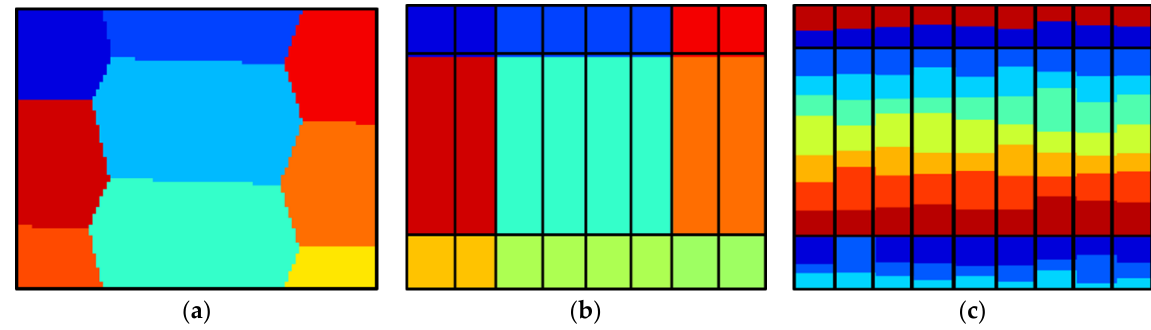
Figure 13. An example of derived seamlines—crossings between different colors—using different strategies: ( a ) closest image nadir point to a given orthophoto cell, ( b ) closest image nadir point to a given row segment, and ( c ) closest image nadir point to a given plant location. The black lines show the row segment boundaries.